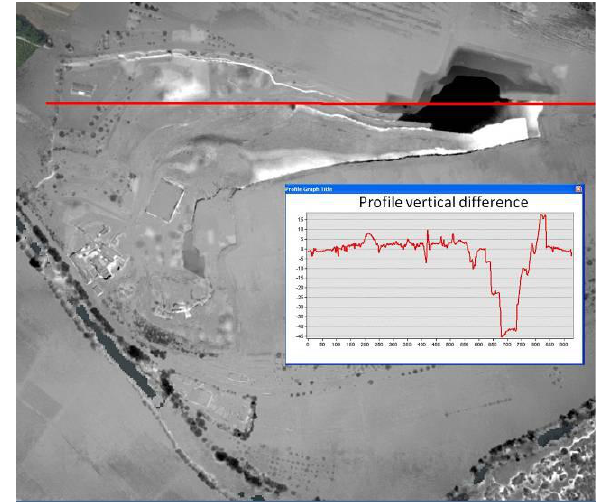
Figure 8: Difference of LiDAR DTM and DSM from UAV image